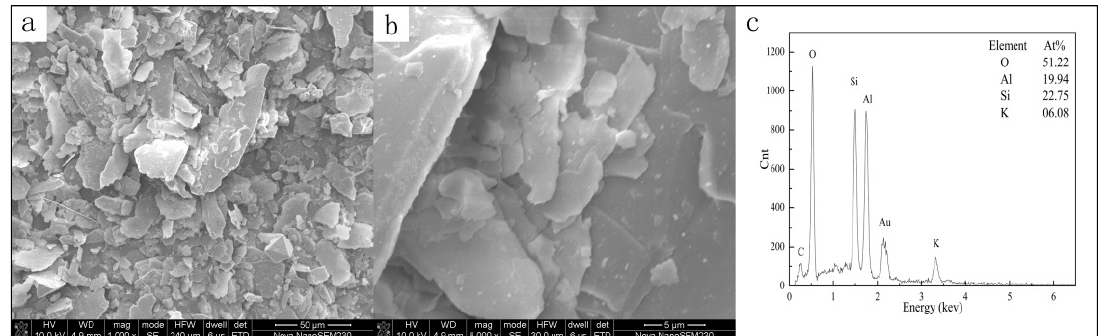
Figure 5. SEM-EDS analysis of raw sericite: ( a ) Magnification is 1000 times and scale bar is 50 μ m; ( b ) Magnification is 8000 times and scale bar is 5 μ m; ( c ) EDS.